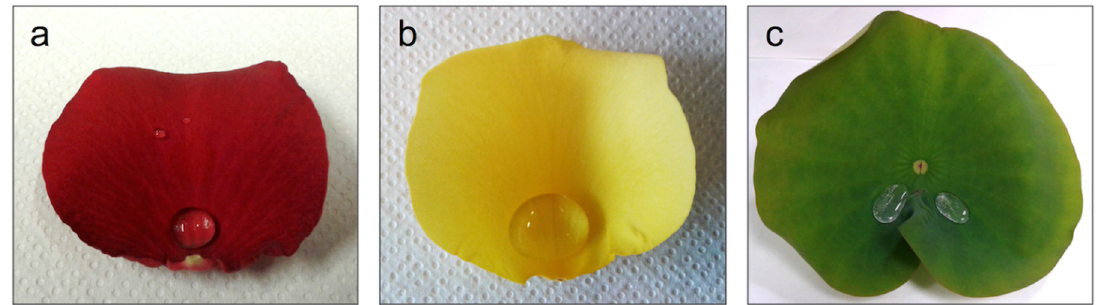
Figure 2. Photographs of ( a ) red rose petal; ( b ) yellow rose petal; and ( c ) lotus leaf with water droplets on them.